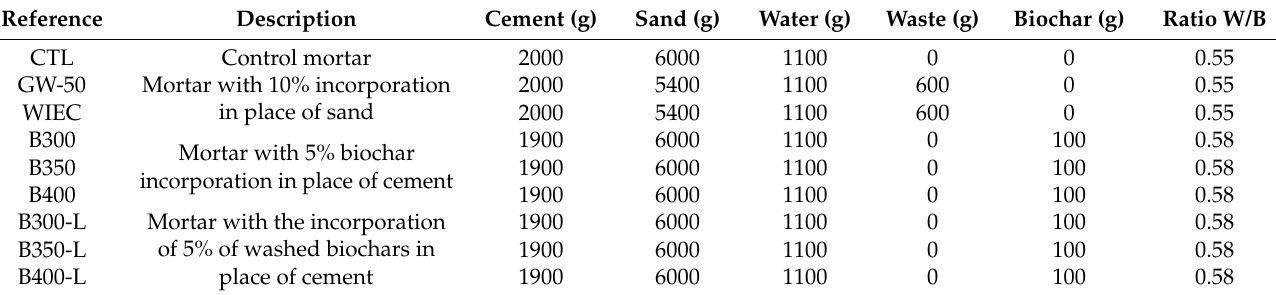
Table 2. Proportion of mixtures from mortar preparation to test